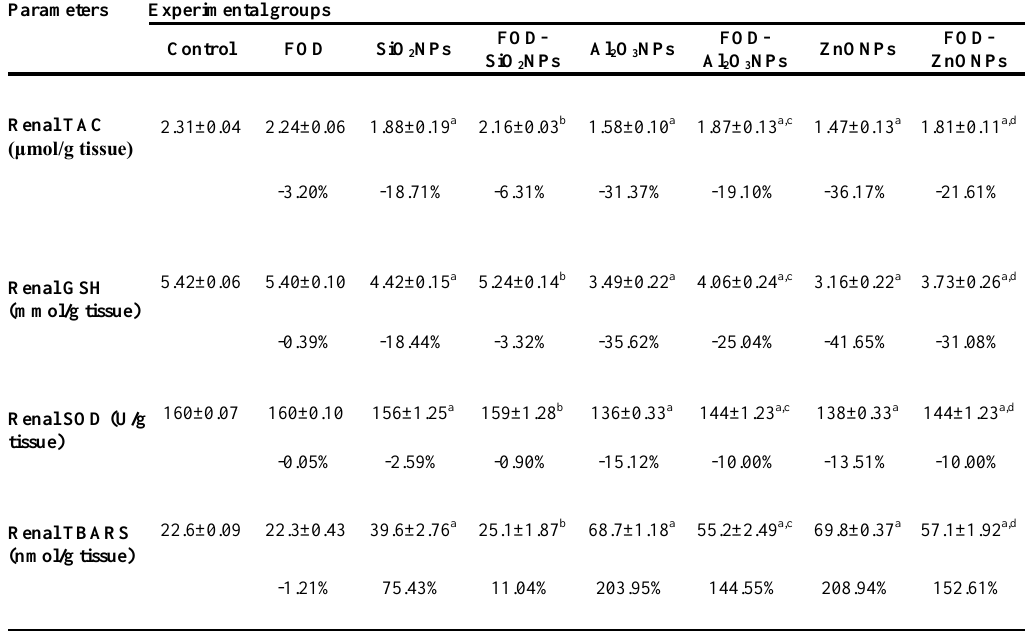
Table 2. The effects of fig with olive oil and date-palm fruit extract on the oxidative stress markers of the kidney tissue of male rats treated with silicon oxide nanoparticles, aluminum oxide nanoparticles, or zinc oxide nanoparticles for 75